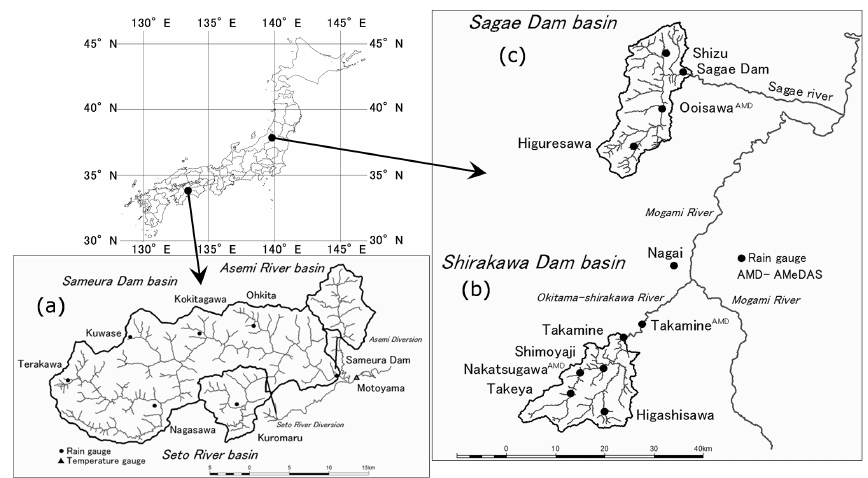
Figure 1. Locations of the four study basins: (a) Sameura Dam basin and Seto River basin within the Sameura Dam basin; (b) Shirakawa Dam basin; and (c) Sagae Dam